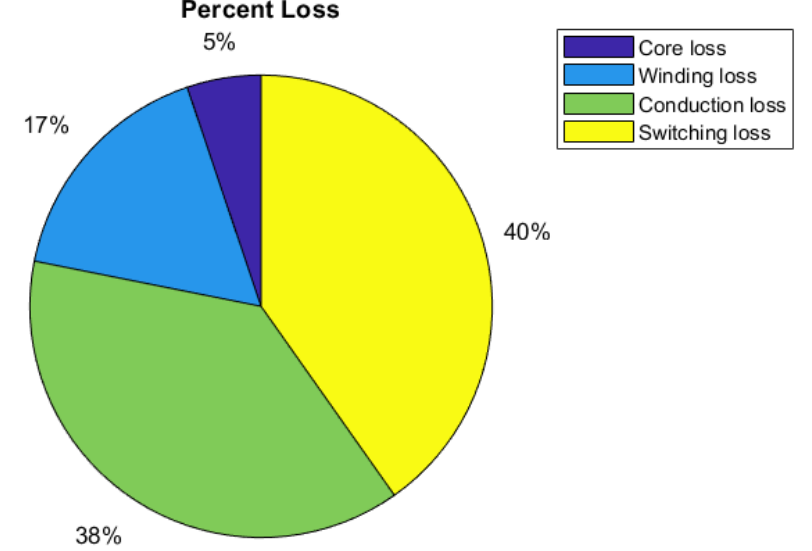
Figure 9. Loss breakdown for Zone-3.